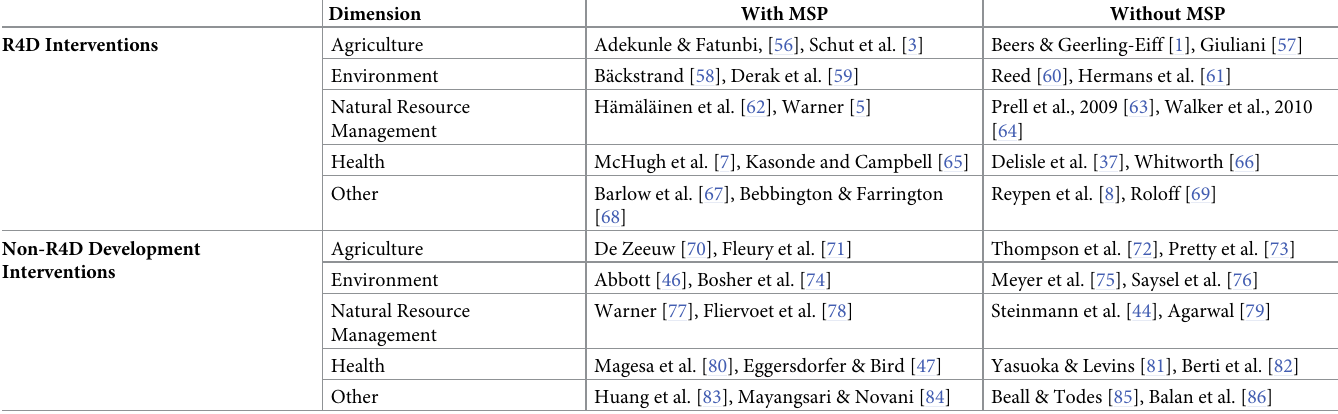
Table 1. Examples of interventions which carry different R4D and MSP characteristics in different R4D fields. Dimension With